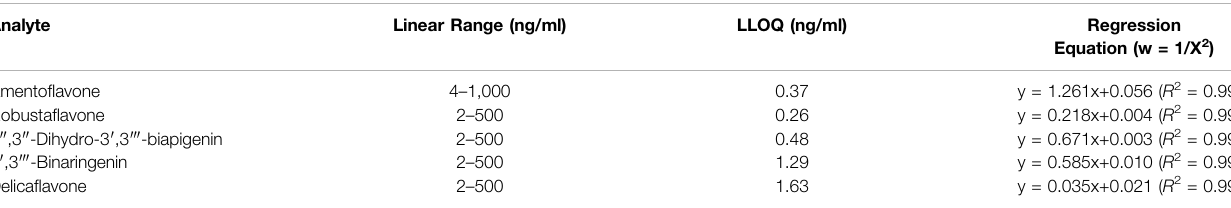
TABLE 1 | Linear regression data of bi fl avonoids in lungs.